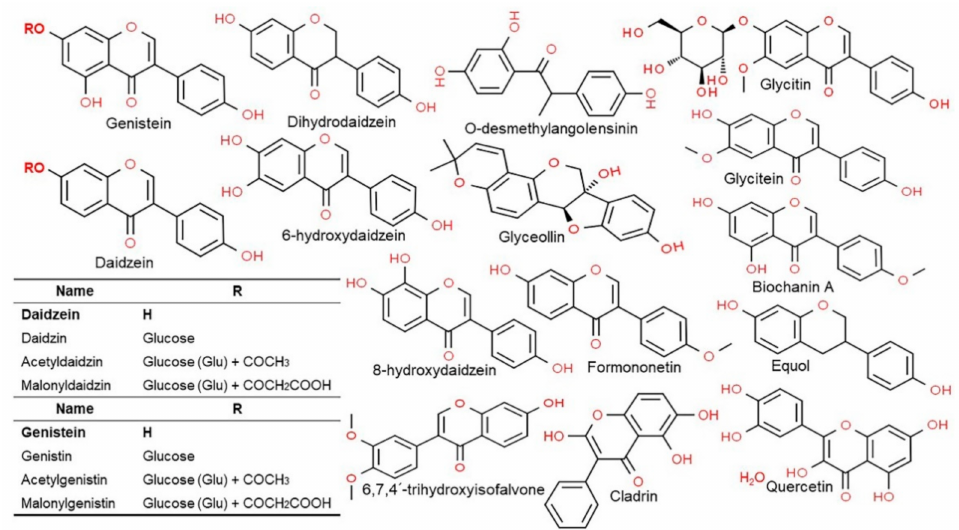
Figure 2. Chemical structures of the major classes of isoflavones and their metabolites. Structures were drawn using the ChemSpider. See the genistein and daidzein backbone in bold before reviewing respective